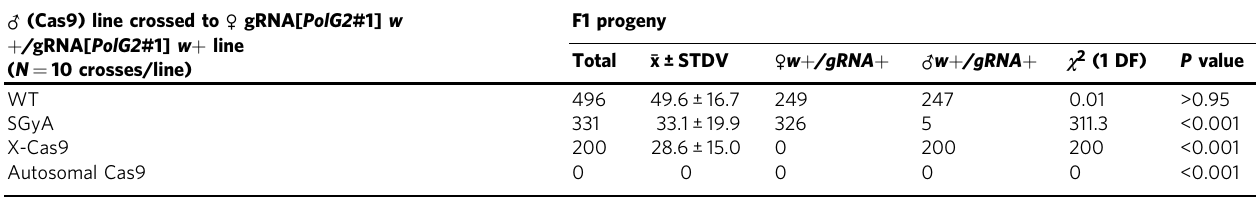
Differences in F1 survival are produced by the activity of the Y-linked Cas9 and autosomal Cas9 in transheterozygous individuals. Negative control used w[1118] males crossed to w + /CyO − females (homozygous for gRNA#1 PolG2 ). The number of individuals observed for each of the four phenotypes from this cross is expected by random assortment ( χ 2 = 0.1, p >0.95). In SGyA experimental crosses, only transheterozygote males ( w + /CyO + ) were killed, whereas females (regardless of their phenotype) and males that inherited the Cas9 transgene but not the gRNA element ( w − /CyO − ) were not affected. Conversely, when females were crossed to males carrying an X-linked Cas9 transgene, only transheterozygous females were killed. The F1 progeny from autosomal crosses